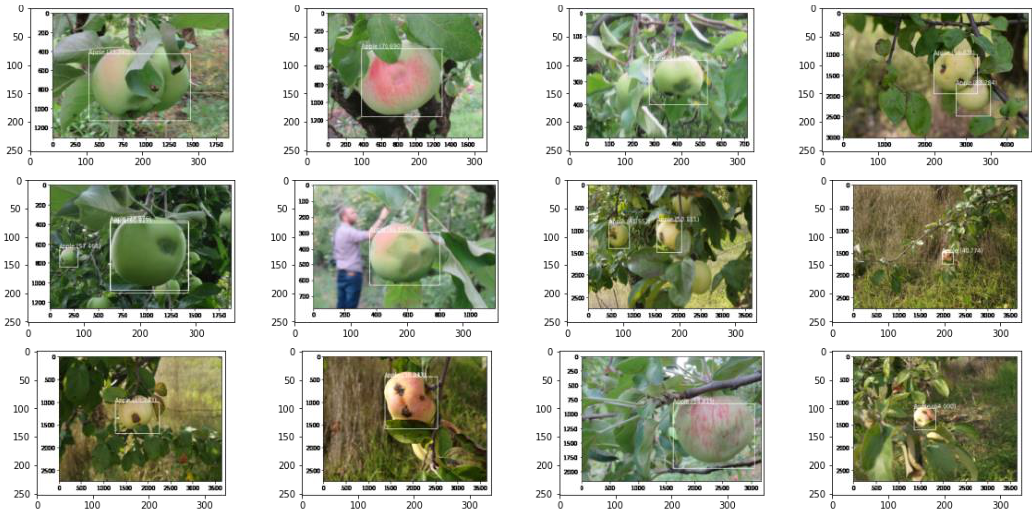
Figure 4. Detecting apples on images with backlight by YOLOv3 without pre-processing ( a ) and with pre-processing ( b ).